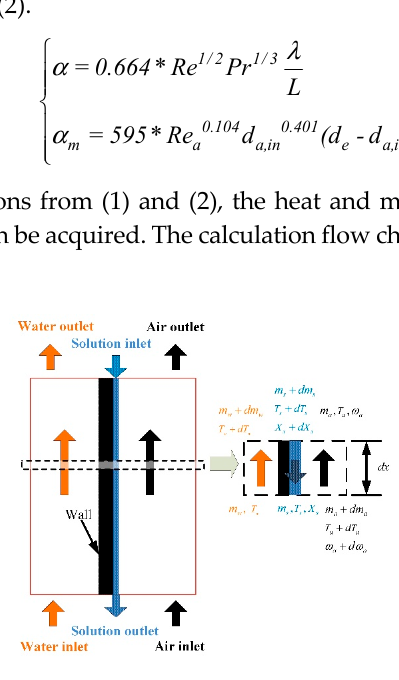
Figure 1. Microelement for the heat and mass transfer.